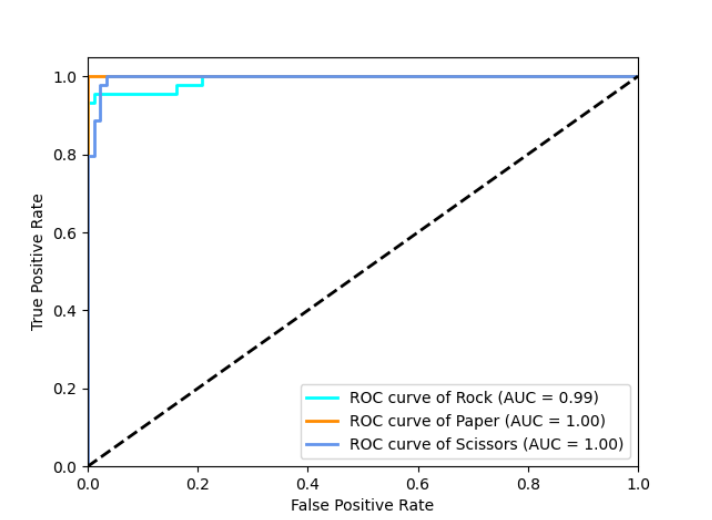
Figure 11. Three ROC curve and its AUC in one experiment. Each ROC curve and its AUC is calculated by taking one class as a positive class and the other two classes as a negative